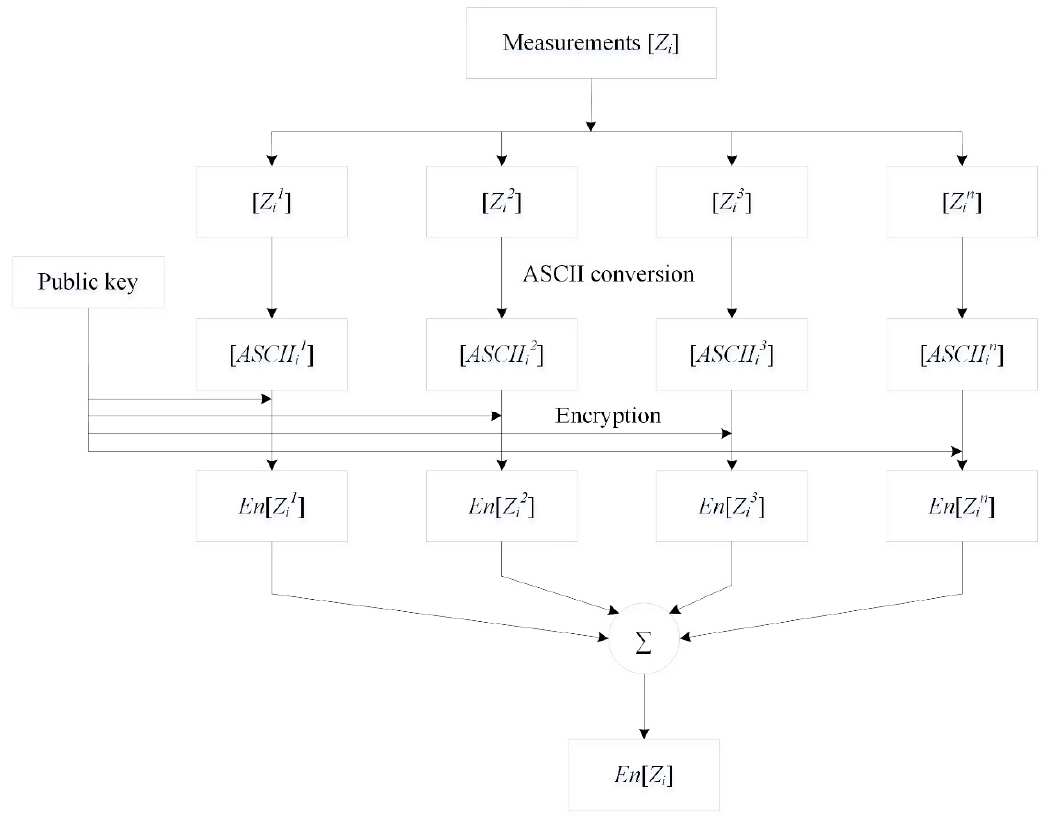
Figure 4. Encryption in the parallel enhanced elliptic curve cryptography (PEECC)